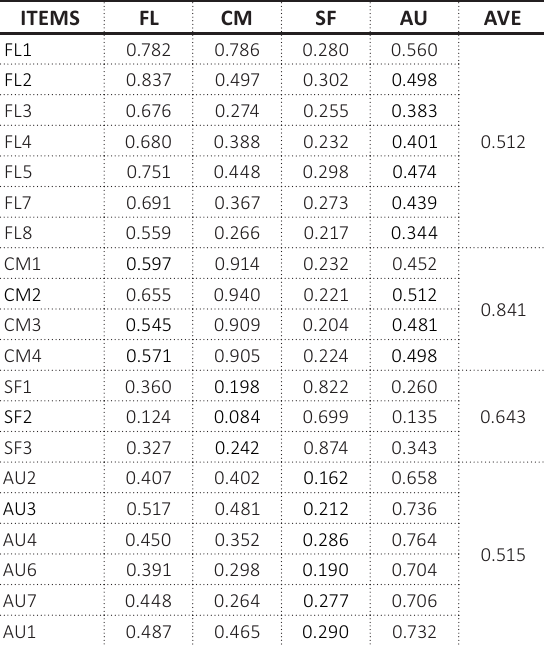
Table 3. Convergent validity results for non-